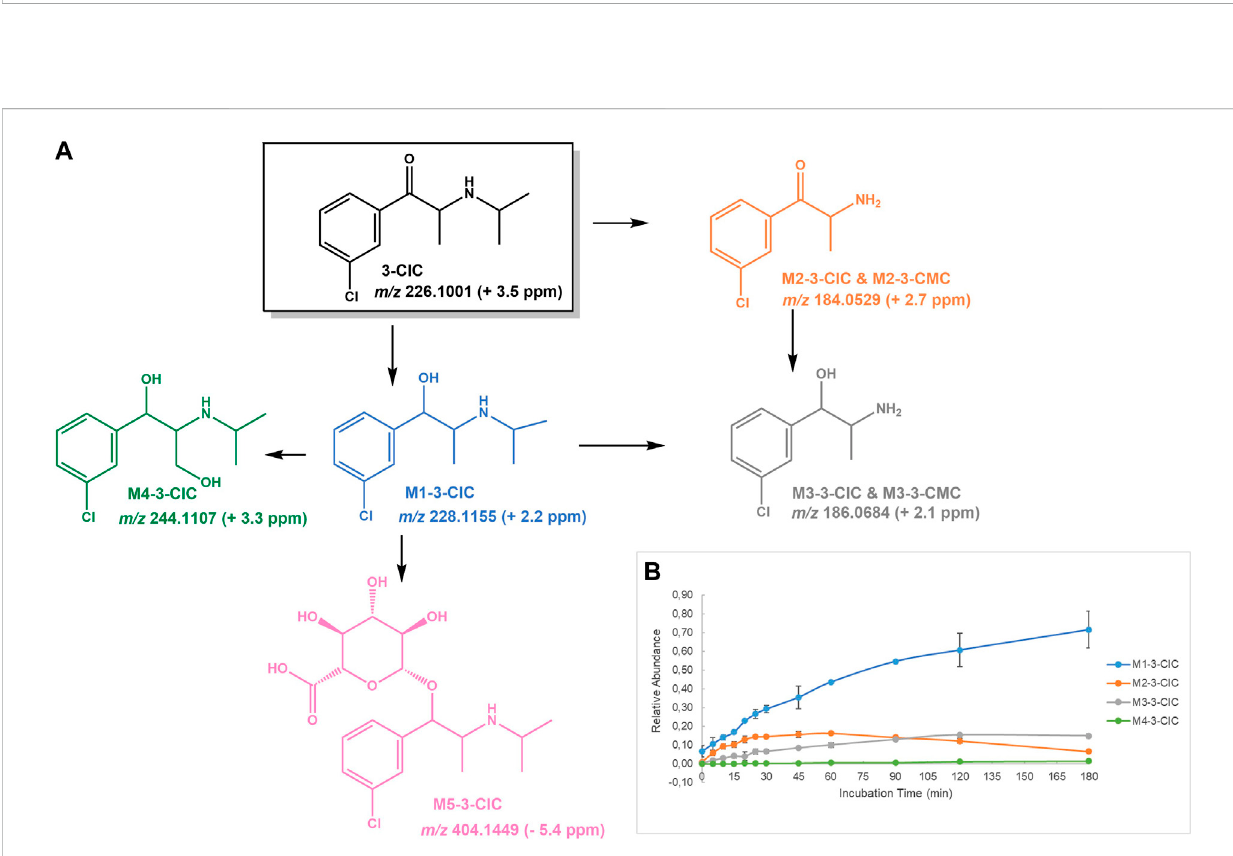
FIGURE 5 (A) Proposedstructuresofthe 3-CIC PhaseIandIImetabolitesidenti fi edbyLC-HRMS/MSanalysisinHLMincubation;and (B) Relativeabundanceof 3-CIC Phase I metabolites over HLM incubation time.